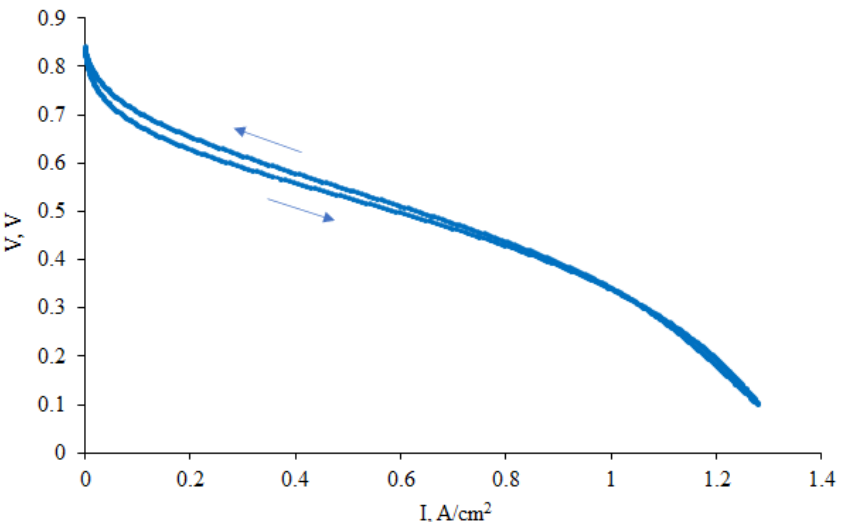
Figure 6. Polarization curve for membrane-electrode assembly (MEA) with platinated CNF/Zr/Ni/Gd composite cathode Pt/1.